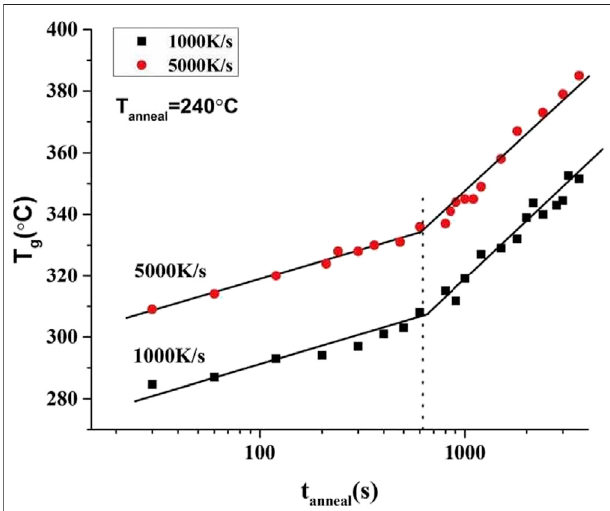
FIGURE 4 | Plots of glass transition temperature Tg and annealing time tanneal with annealing temperature of 240 ° C for Al 88 Y 7 Fe 5 under two different heating rates of 1,000 and 5,000 K/s. For two heating rates, both of the plots of Tg and tanneal show the breaking points and the values of the breaking points are very close, which implies that the determined delay time does not depend on the used heating rates. (from Shen et al.